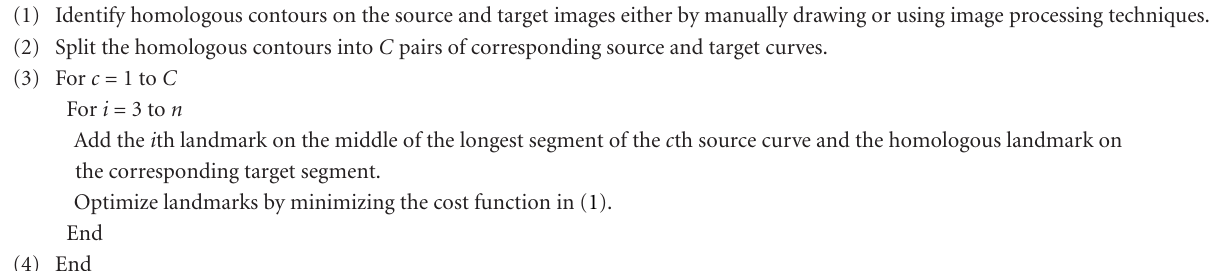
Table 1: Pseudocode of the landmark generation and optimization